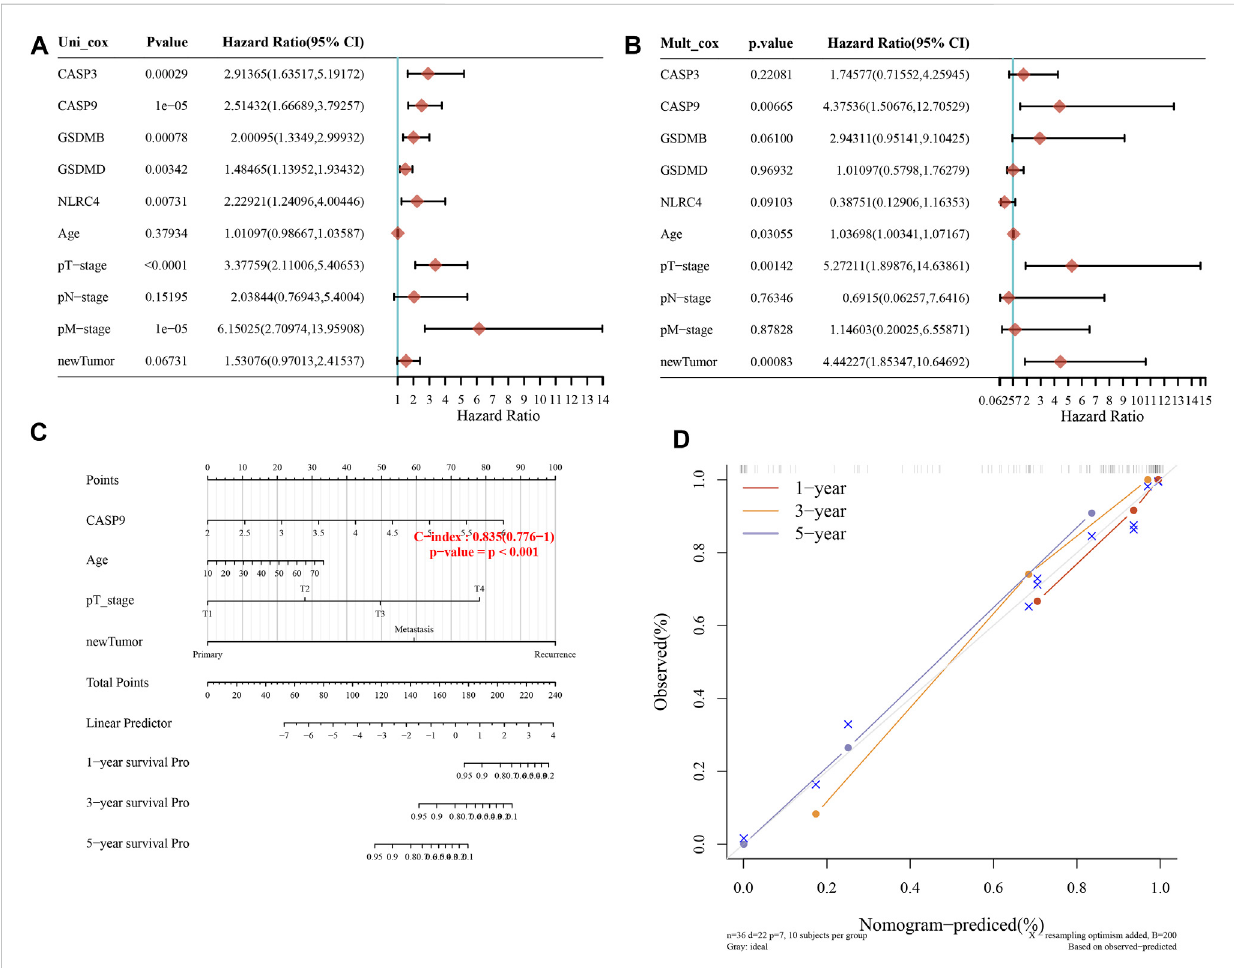
FIGURE 6 Constructing the predictive nomogram. (A, B) Hazard ratio and p -value of the constituents involved in univariate and multivariate Cox regression considering clinical parameters and fi ve prognostic PRGs in ACC. (C) The 1-year, 3-year, and 5-year overall survival rates of ACC patients were predicted by the nomogram. (D) Calibration curve for the overall survival nomogram model in the discovery